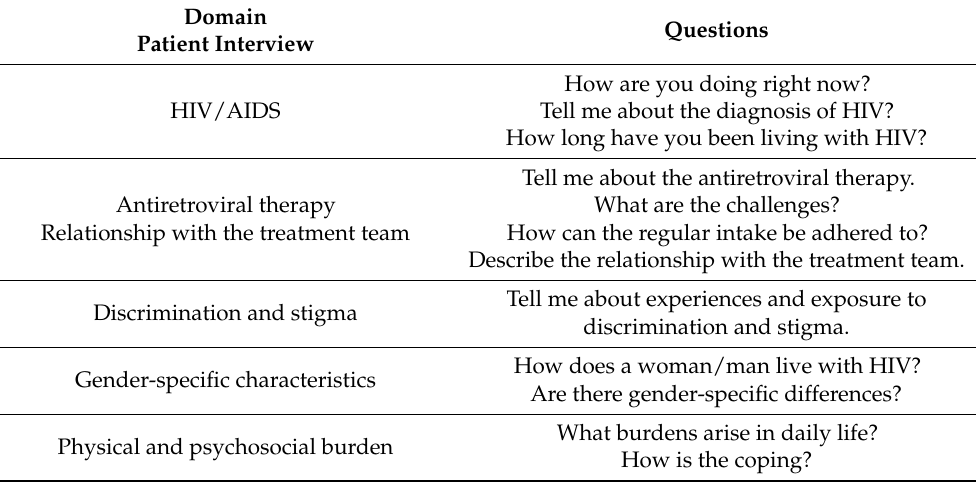
Table 1. Sample qualitative interview agenda questions.